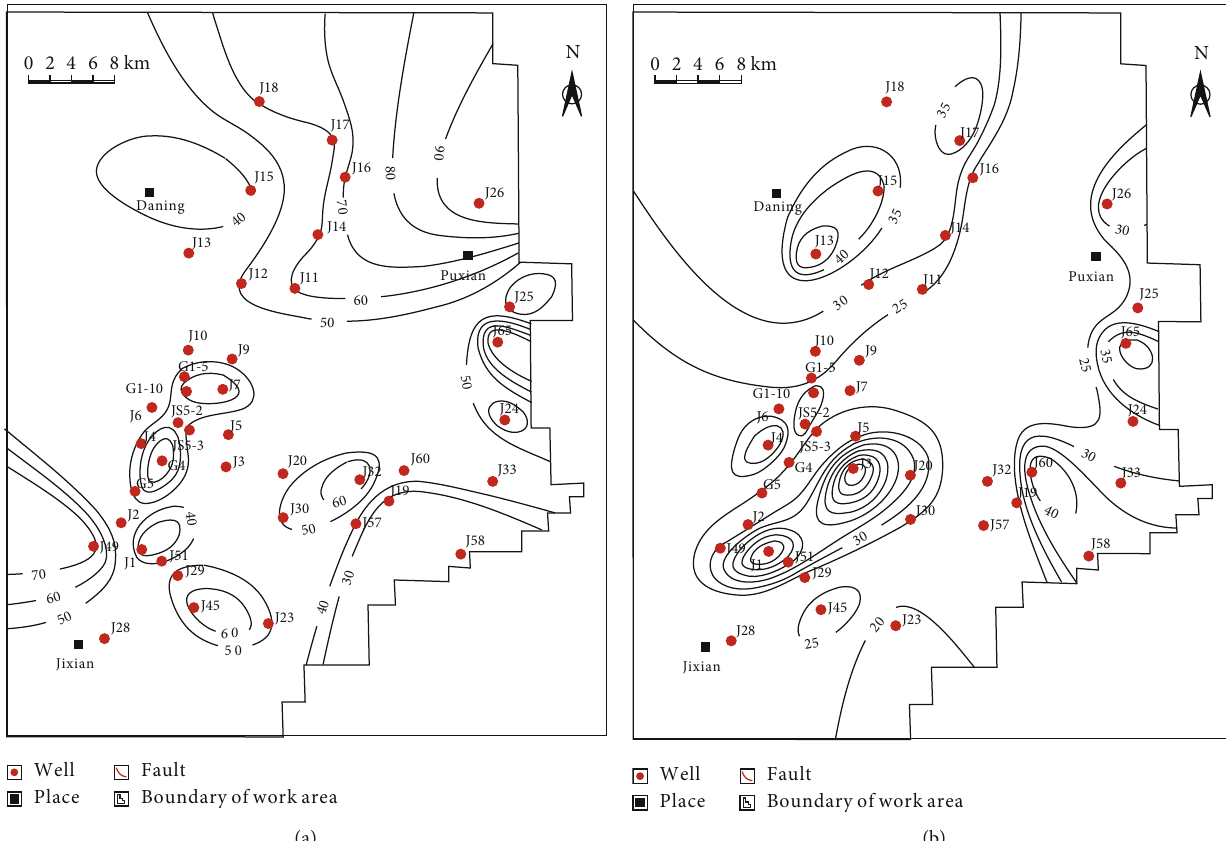
Figure 5: The contour map of the thickness of the mud (shale) reservoirs in the study area. (a) Shanxi Formation; (b) Taiyuan